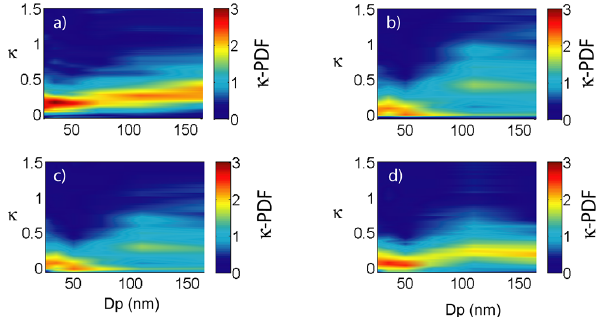
Figure 4b. Average κ -PDFs as a function of particle diameter, split by season and measured at RH90: (a) represents winter, (b) spring, (c) summer and (d)